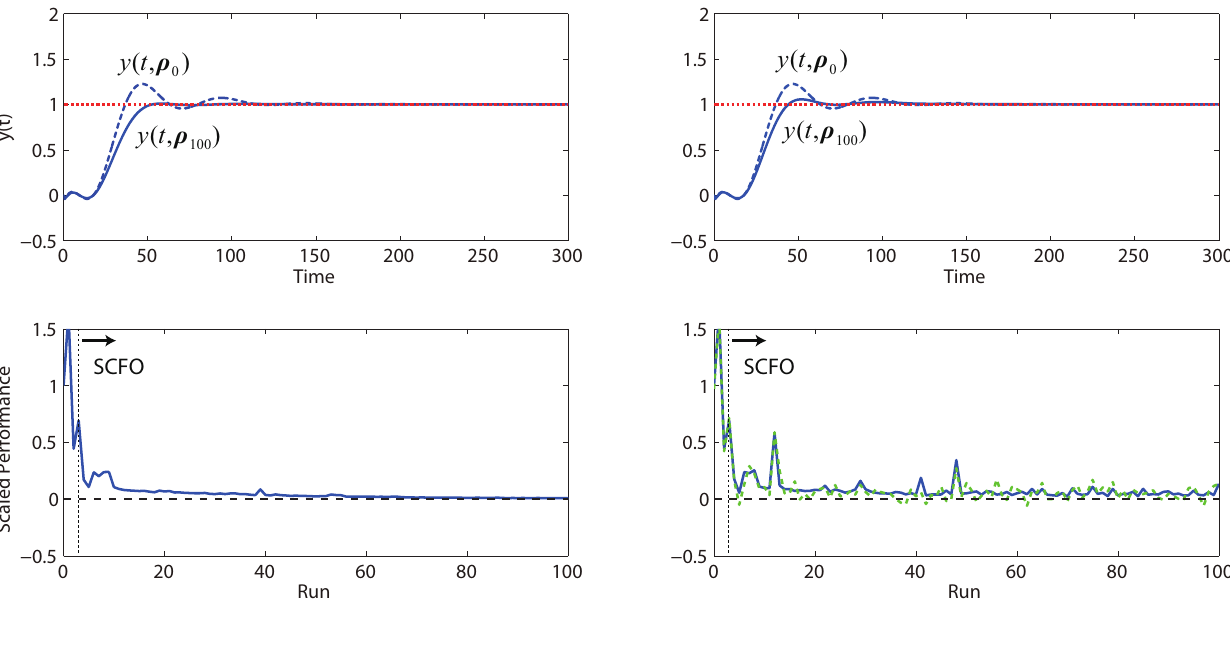
Figure 15. Performance obtained by iterative tuning for Study 3 of Problem